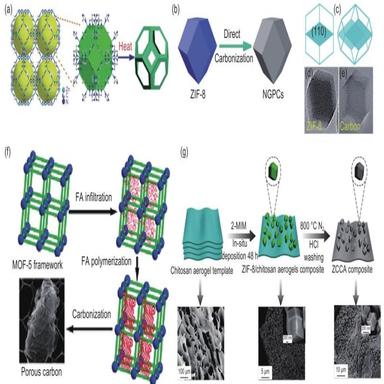
a-b) Schematic illustration of the ZIF-8 derived highly graphitized NGPCs. (c) The corresponding rhombic dodecahedron-like structural models of ZIF-8 and NGPCs. (d-e) TEM images of typical ZIF-8 and NGPC polyhedron nanoparticle, respectively. Reproduced with permission. Copyright @ 2014 Royal Society of Chemistry. (f) Schematic illustration of the FA/MOF-5 composites derived highly porous carbon and its corresponding SEM image. Reproduced with permission Copyright © 2008 American Chemical Society. (g) Schem